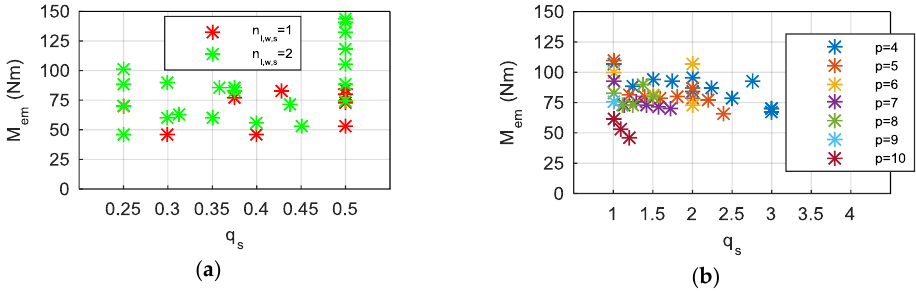
Figure 8. Mean electromagnetic torque ( M em ) versus number of stator slots per pole and phase ( q s ) ( a ) and slot layer number ( n l,w,s ) for FSCW machines; ( b ) and pole pair number ( p ) for ISDW and FSDW machines.